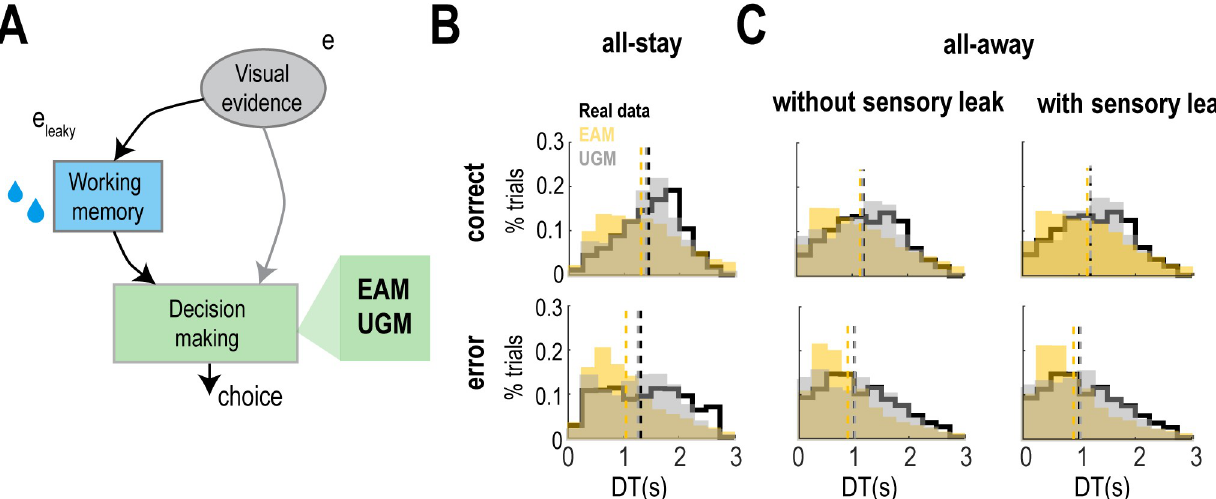
Fig 4. Computational framework and model simulations for correct and error trials. (A) Schematic diagram of the complete network that simulates the observed experimental results. Visual evidence is either provided directly to the decision-making module or stored in a working memory that then provides the information ( e leaky ) to the decision-making module. The information ( e leaky or e ) is used by the EAM or the UGM to make a choice. (B) Distributions of DTs in correct and error trials in the all-stay condition when all individual trials are pooled together for real data and simulated EAM and UGM. (C) Same conventions as in (B) for the all-away condition. In this case, simulations were performed with and without leakage in the sensory evidence.